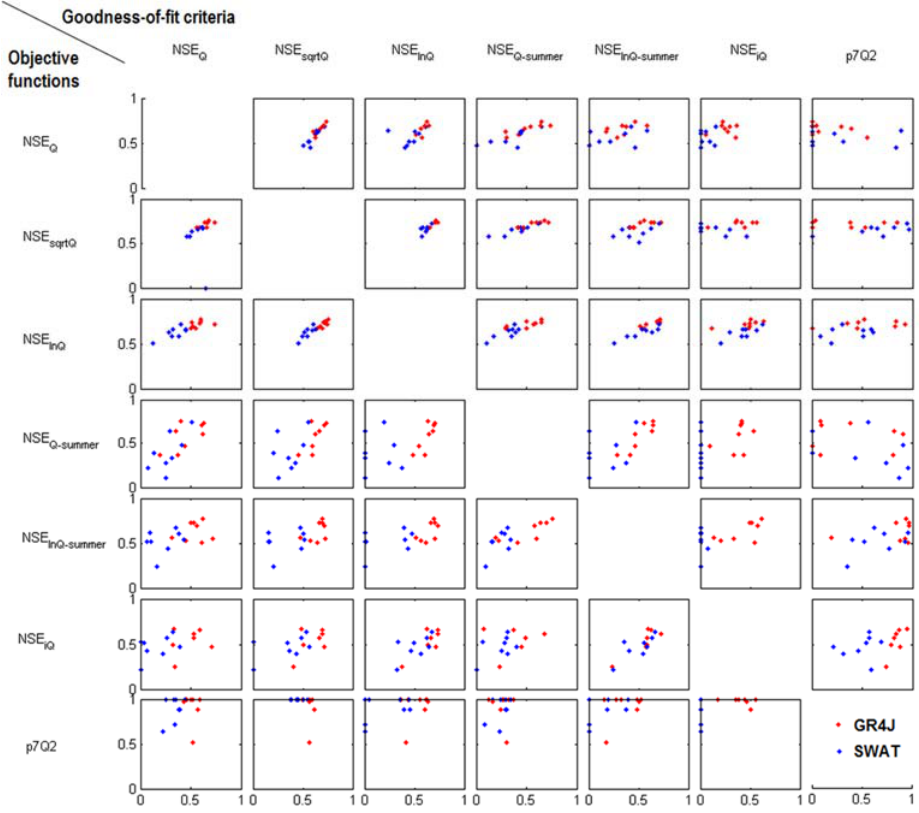
Figure 4. Relationship between objective function values and goodness-of-fit criteria for the best simulation.